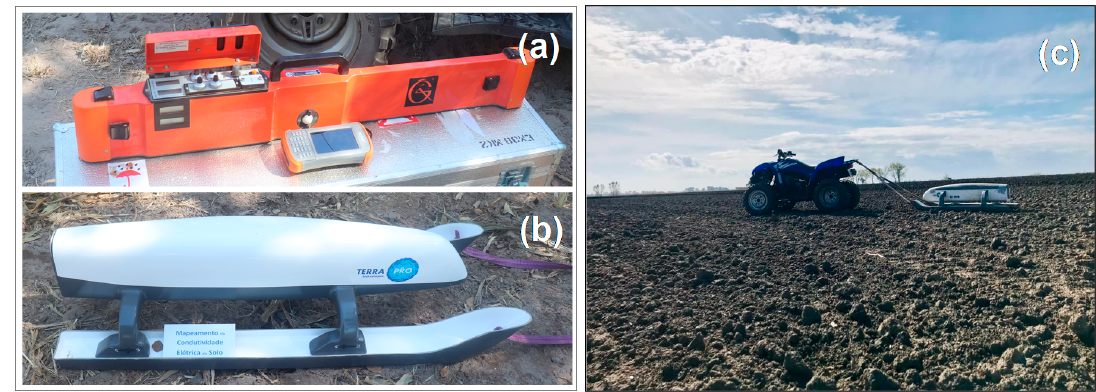
Figure 3. Electromagnetic induction device (EM38) ( a ), transport platform, ( b ) and sensor in field work ( c ).